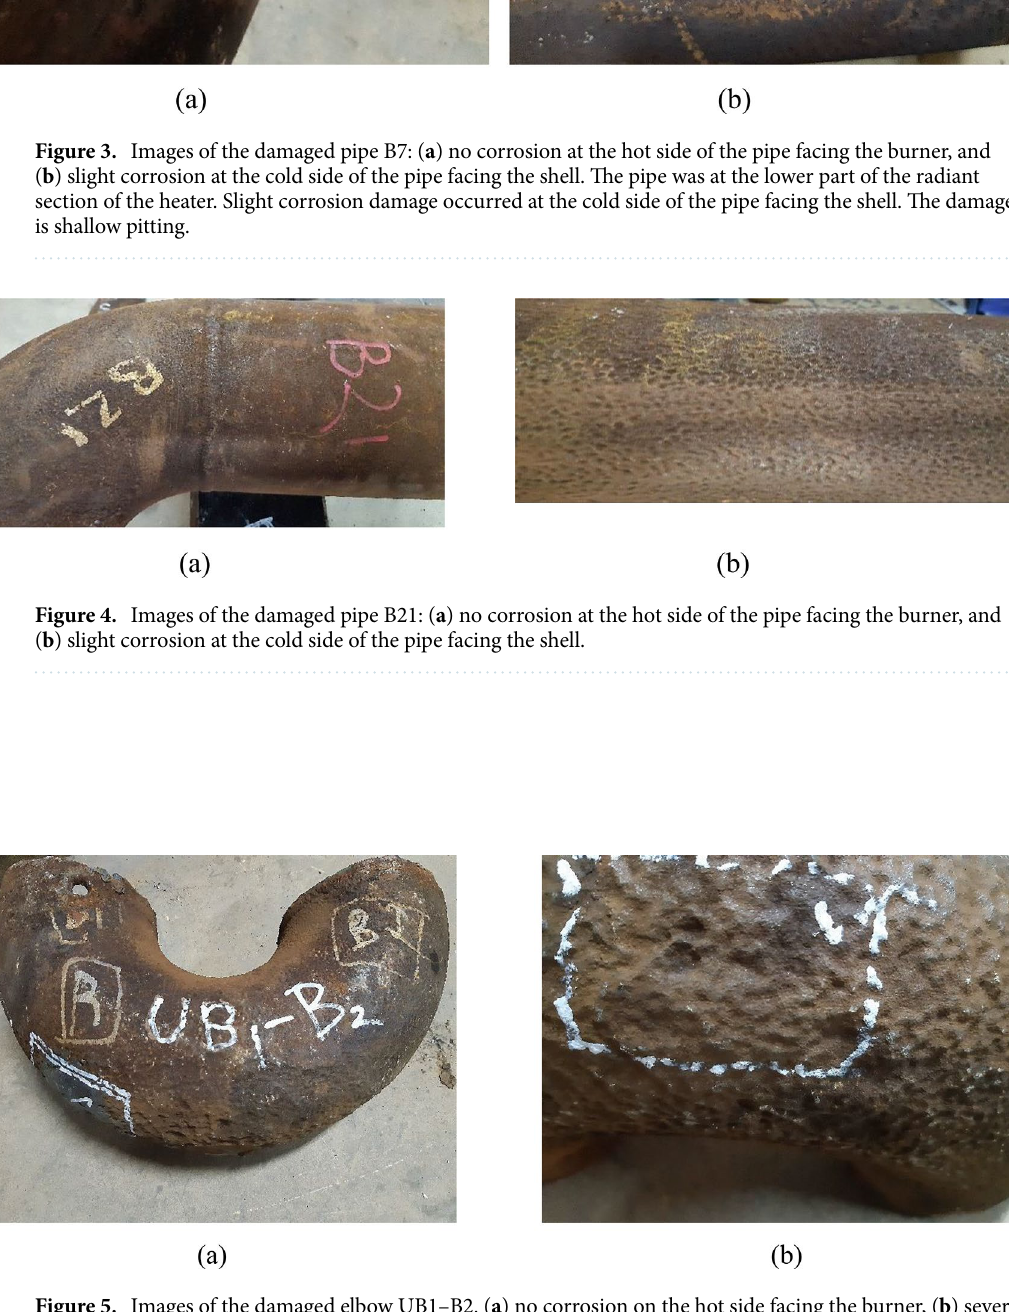
Figure 5. Images of the damaged elbow UB1–B2. ( a ) no corrosion on the hot side facing the burner, ( b ) severe corrosion at the U bend and the cold side facing the shell. The elbow was at the lower part of the radiant section of the heater, and the U bend was down in service. Corrosion damage occurred at the bottom of the elbow and on the cold side facing the heater shell. The damage is coarse and shallow